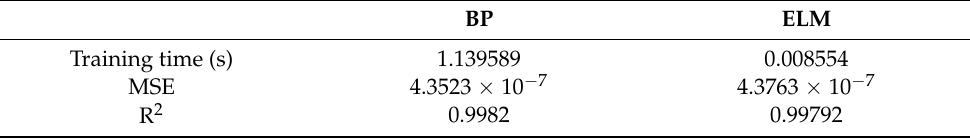
Table 1. Comparison of training data between BP neural network model and